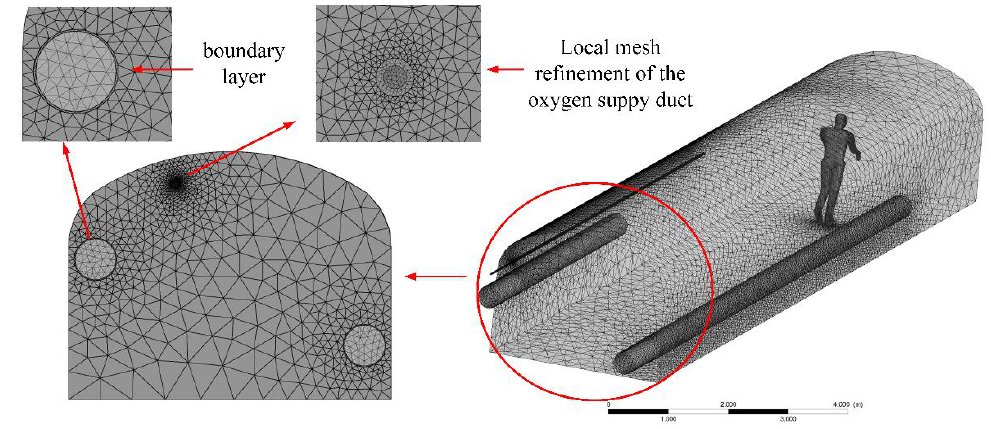
Figure 3. Generation of the roadway grid. Table 1. Grid metrics information.